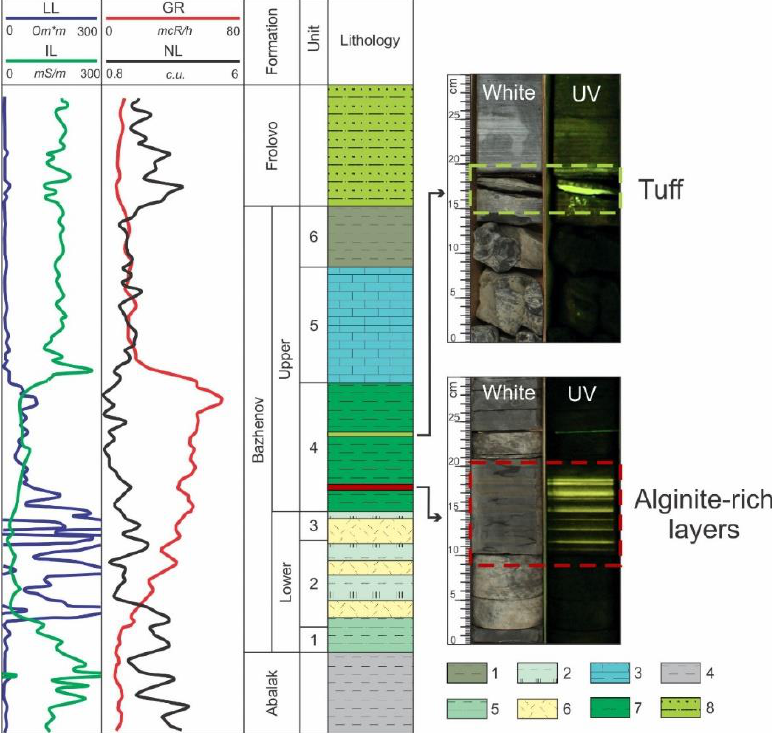
Figure 2. Example of the Bazhenov Formation cross-section. Core photographs under white and UV light. Lithology: 1, siliceous claystone; 2, siliceous rocks with low clay content; 3, organic-rich calcareous rocks; 4, claystone; 5, organic-rich claystone; 6, radiolarite; 7, organic-rich siliceous rocks; 8, alternation of siltstones, claystone, and sandstones. Well-logs: LL, laterolog; IL, induction log; GR, gamma-ray log; NL, neutron log.